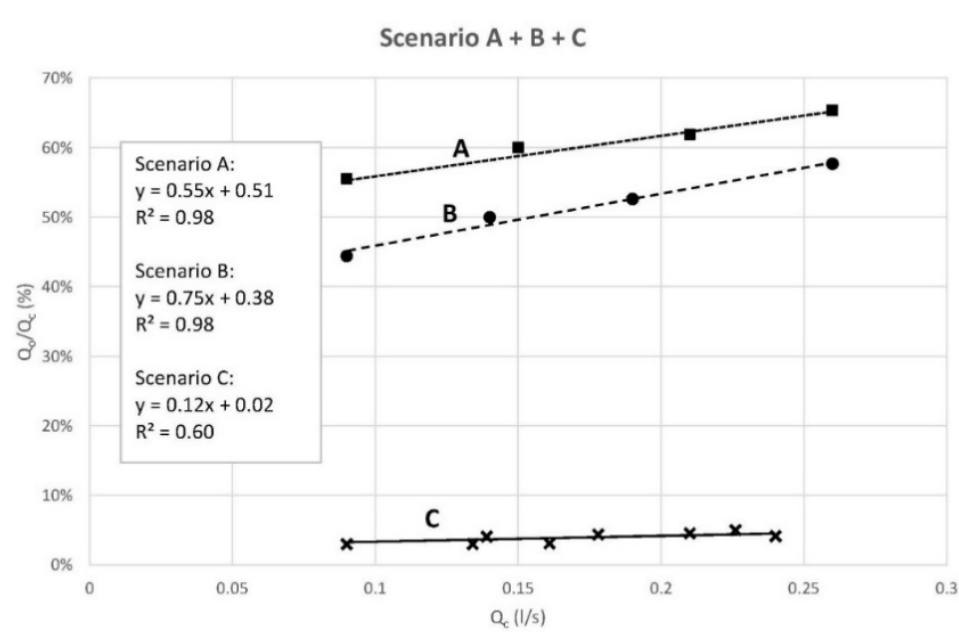
Figure 6. Dependence of the Q o / Q c parameter on the total flow rate Q c —Scenario A, B, and C.